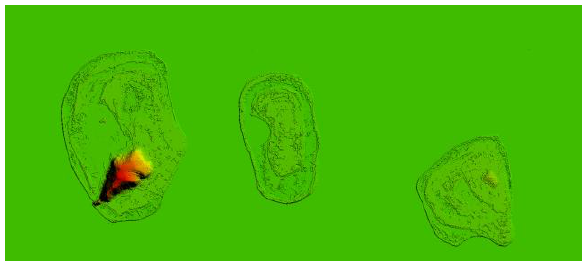
Figure 9. LiDAR DEM from point cloud LiDAR